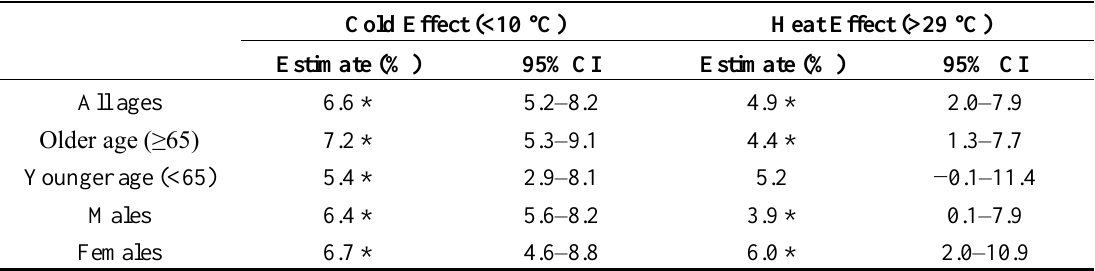
Table 2. The Cumulative Effect of Cold- (25 lag days) and Heat- (3 lag days) Related CVD